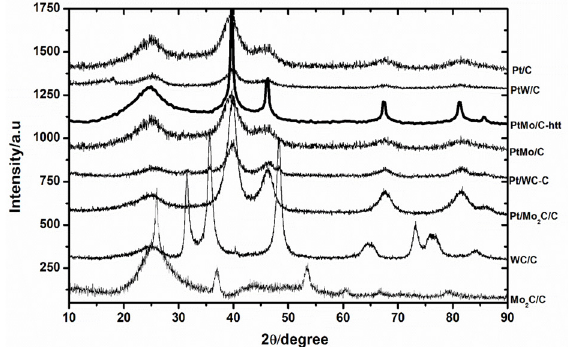
Figure 1 - XRD patterns of carbon supported molybdenum carbide and tungsten carbide (Mo C/C and WC/C) supports, 2 Pt supported on these carbide supports, PtMo-heat treated